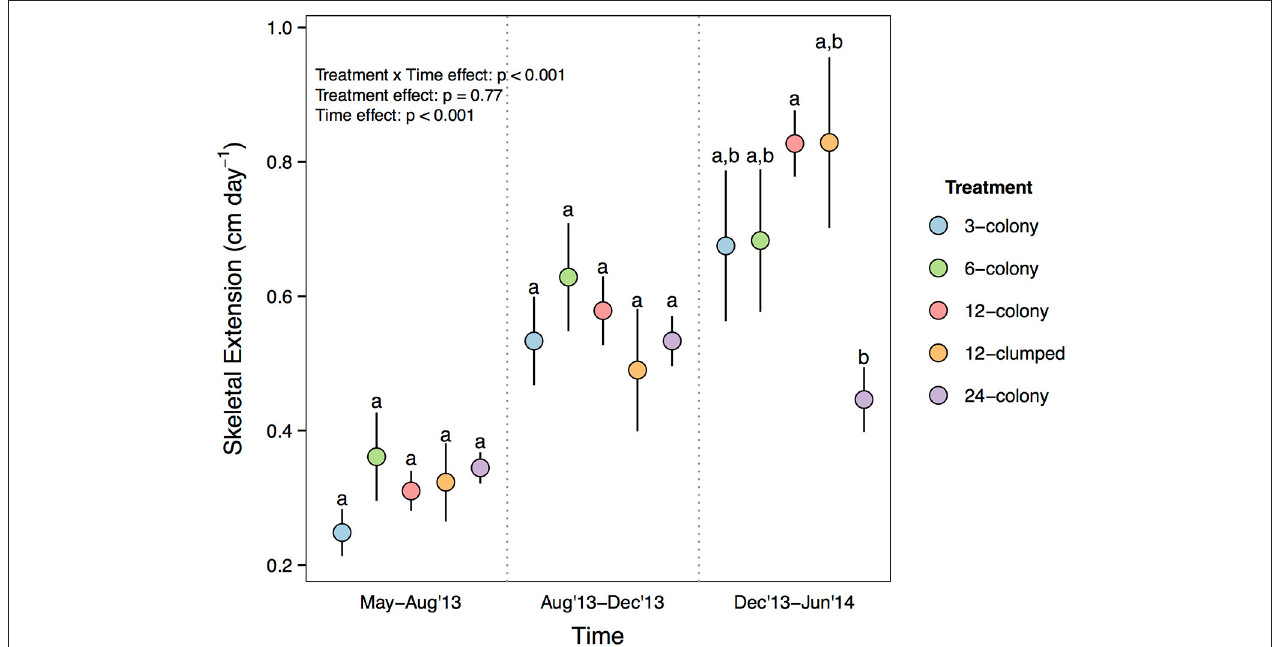
FIGURE 2 | Daily growth rate (cm day − 1 ) of individual corals by treatment through time. Labels on x-axis indicate the time period over which growth rates were calculated. Statistics are from nested two-way repeated measures ANOVA. Letters represent significant differences ( p < 0.05) among treatments within a time period from post-hoc tests with Tukey’s correction. Data are means ±